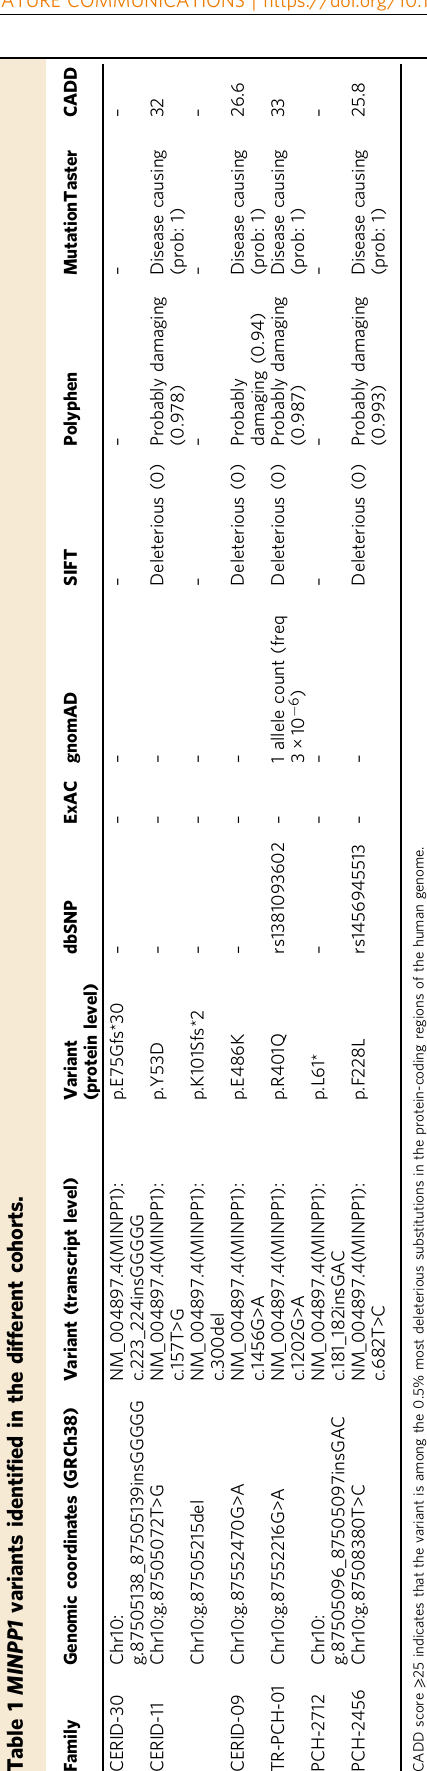
subtype that we propose as PCH type 14.